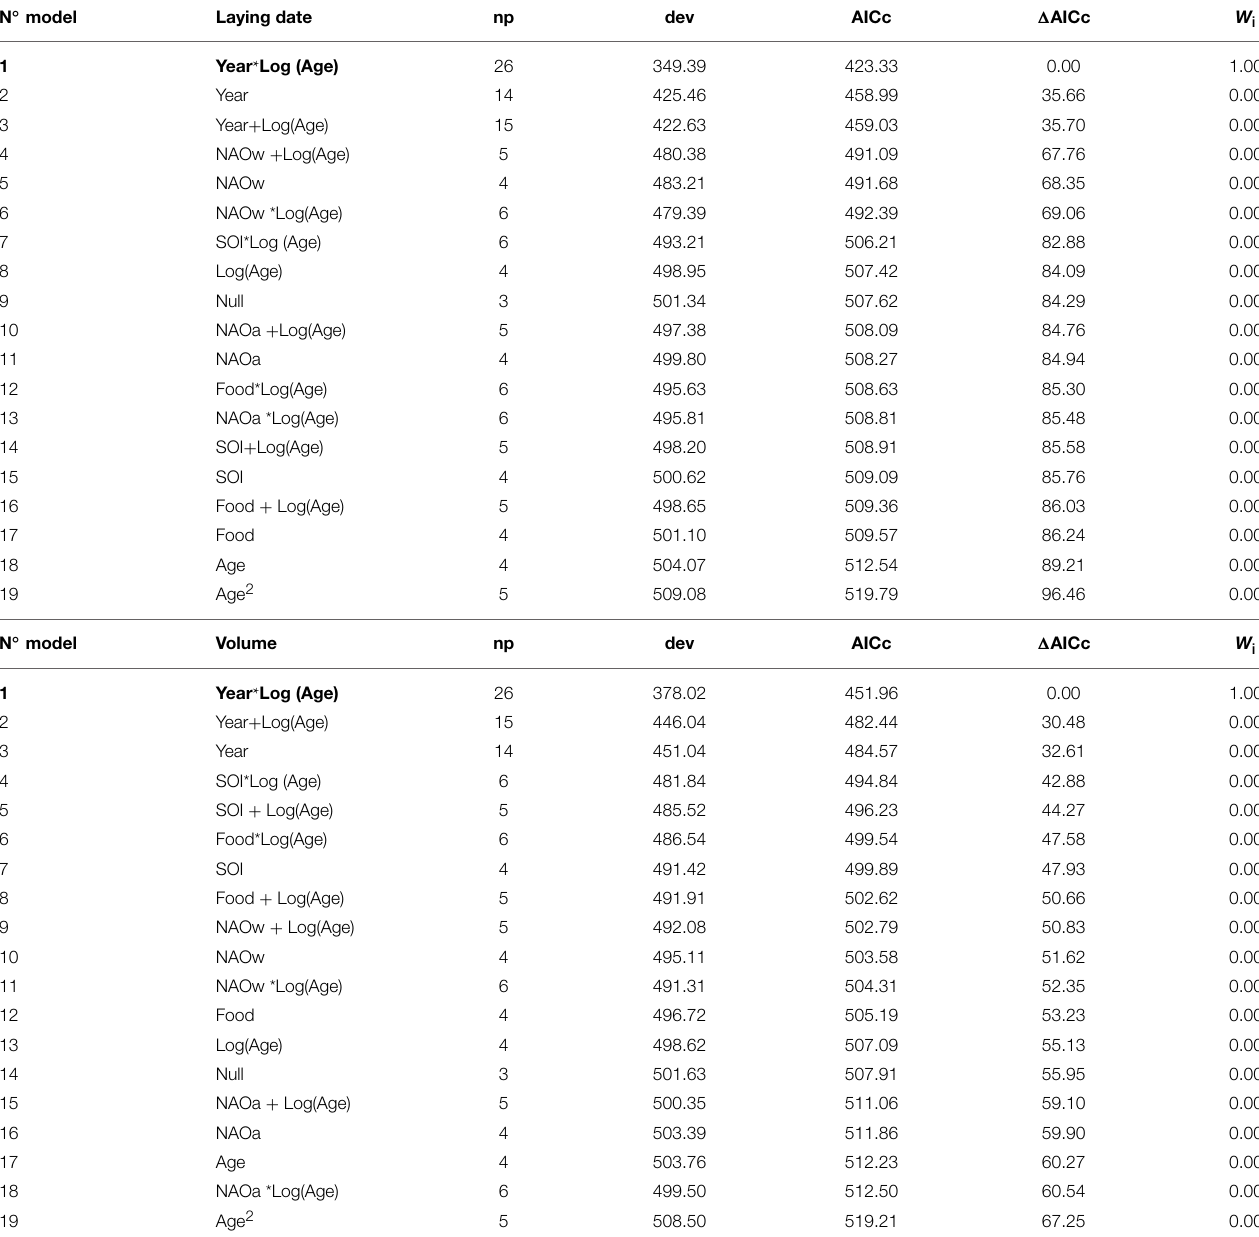
TABLE 1 | Modeling the effects of age and environmental conditions on the breeding parameters of Scopoli’s Shearwater’s using generalized linear mixed models. N ◦